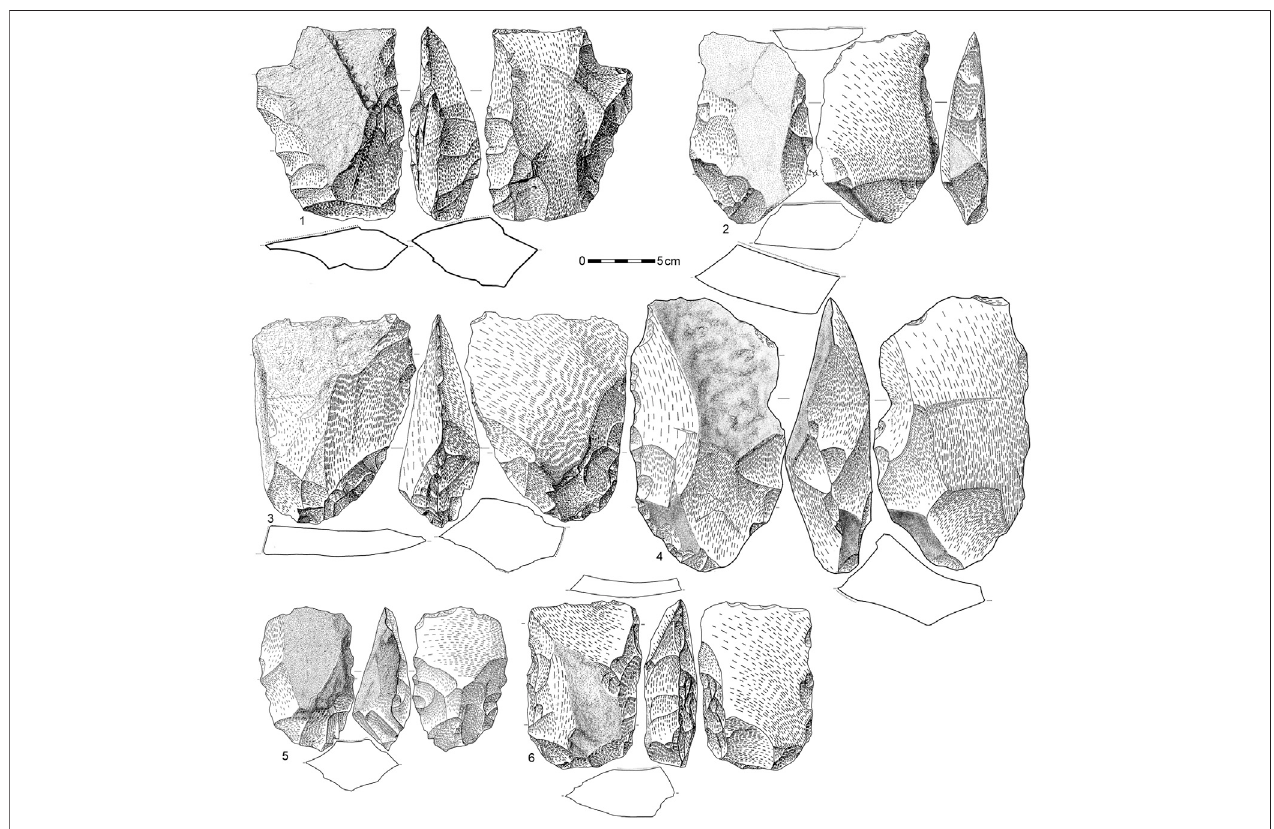
FIGURE 11 | Cleavers on fl ake of type 0 (1, 2), of type 0 with extensive and deep knapping (3-5) and cleaver of type I (6). All on quartzite.